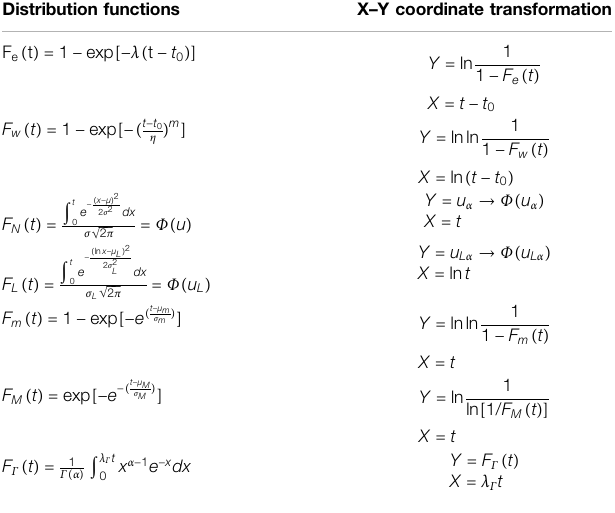
TABLE 2 | Design of different probability plots. Distribution functions X – Y coordinate